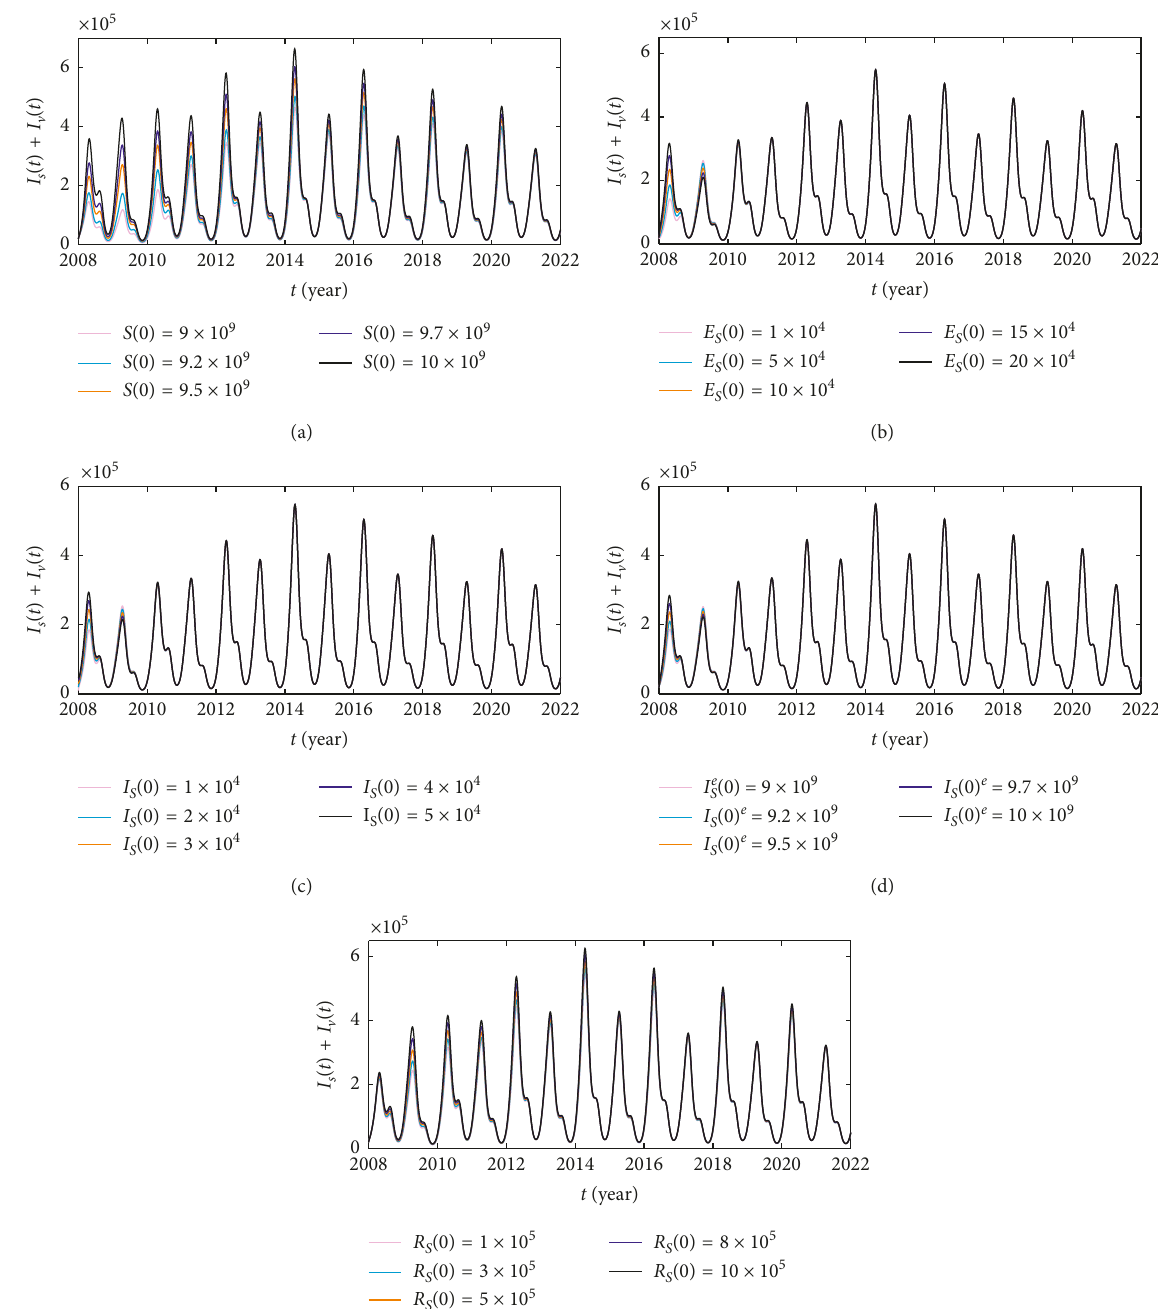
Figure 4: The influence of initial conditions of humans on the number of HFMD cases I values of E s ( 0 ) ; (c) different values of I s ( 0 ) ; (d) different values of I e s ( 0 ) ; (e) different values of R s ( 0 )